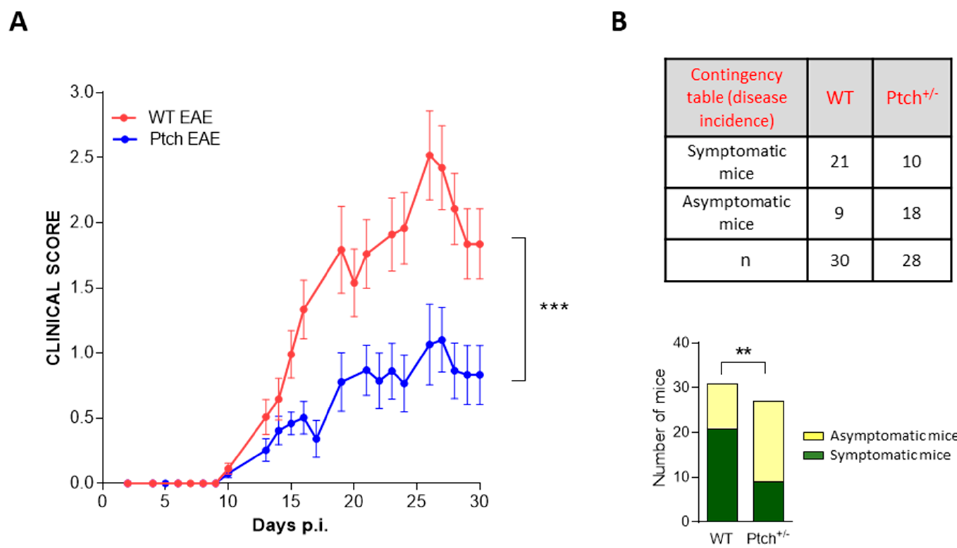
Figure 6. Progression of EAE in ptch +/ − and wt mice. Groups of 12–16 mice were induced to EAE by using MOG 35–55 peptide inoculation. ( A ): Daily clinical score. Values were obtained from the mean of two experiments. ( B ): Disease incidence contingency table. Each individual mouse was considered symptomatic for disease onset data only if it maintained a score greater than one for at least three days. The bar graphs for representation of the disease incidence contingency table show the number of symptomatic and asymptomatic mice at day 30 p.i. for each group. The n values are indicated on the table. Statistical significance is indicated as ** p < 0.01 and *** p < 0.001. Standard errors of the means are shown.